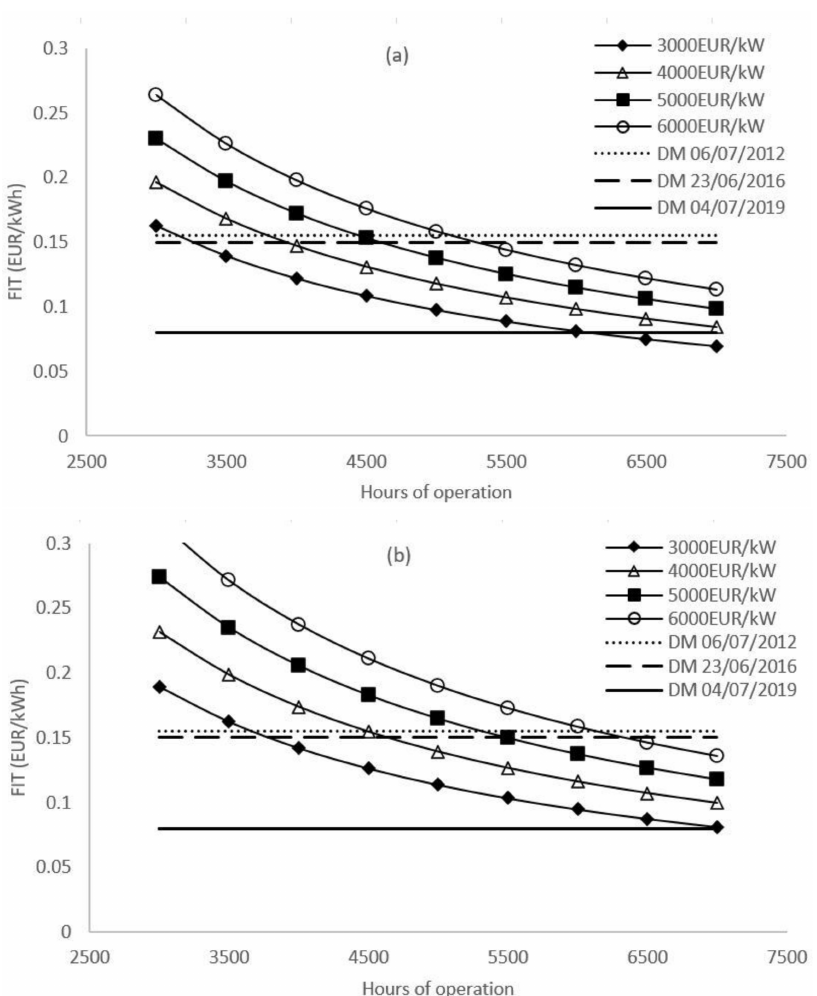
Figure 10. Feed in tariff vs. hours of operation for different capital expenditures to reach internal rate of return equal to 7% ( a ) and 9% ( b ); plant size is 1000